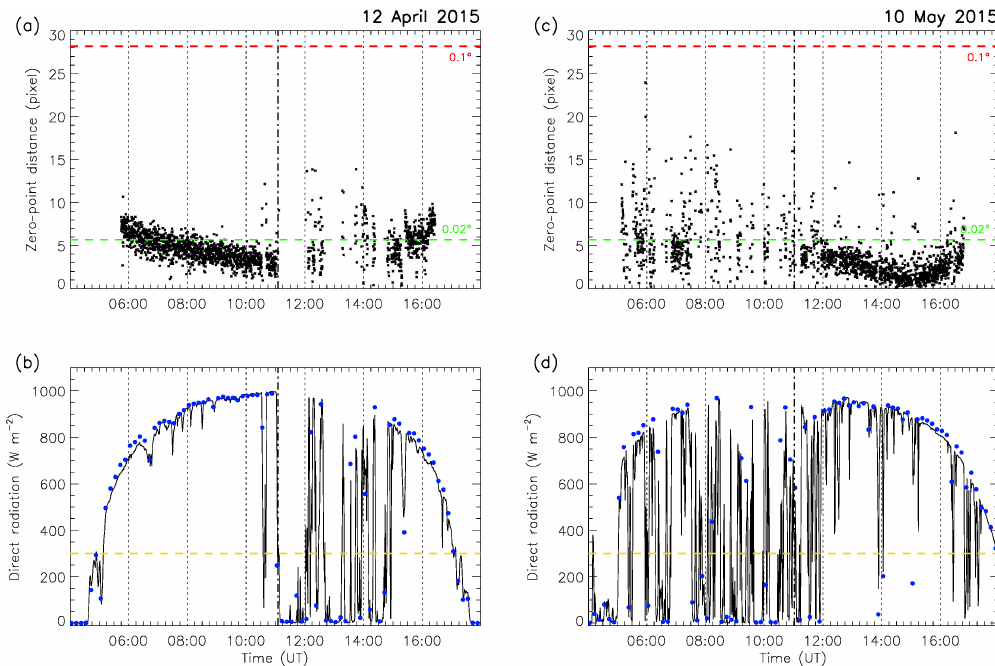
Figure 7. As Fig. 6, but for days with variable cloud cover (left, 12 April 2015; right, 10 May 2015).